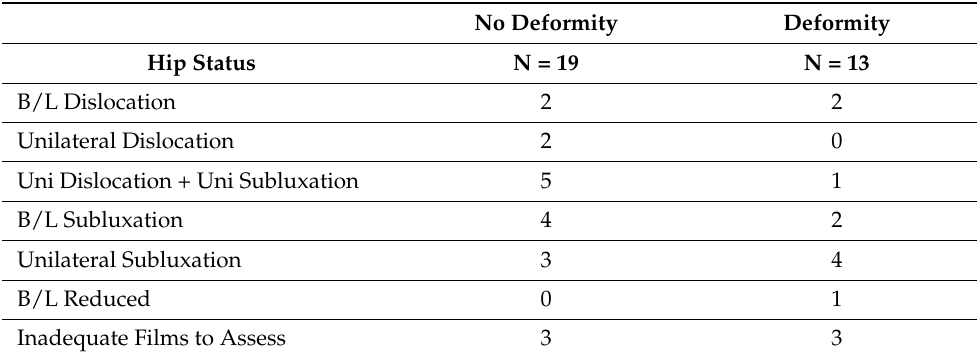
Table 8. Comparison of hip status between those with and without